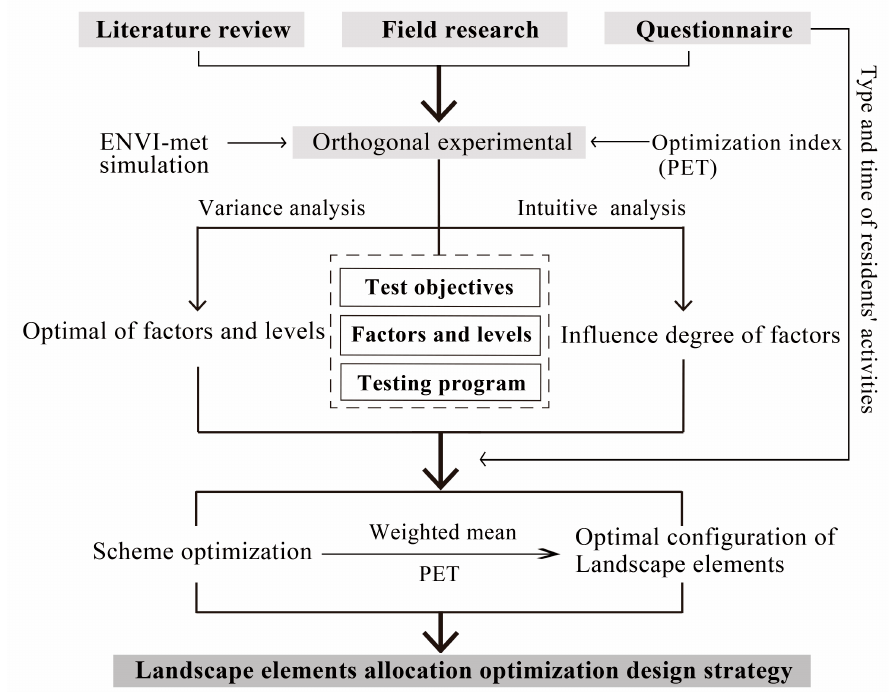
Figure 5. Research framework.